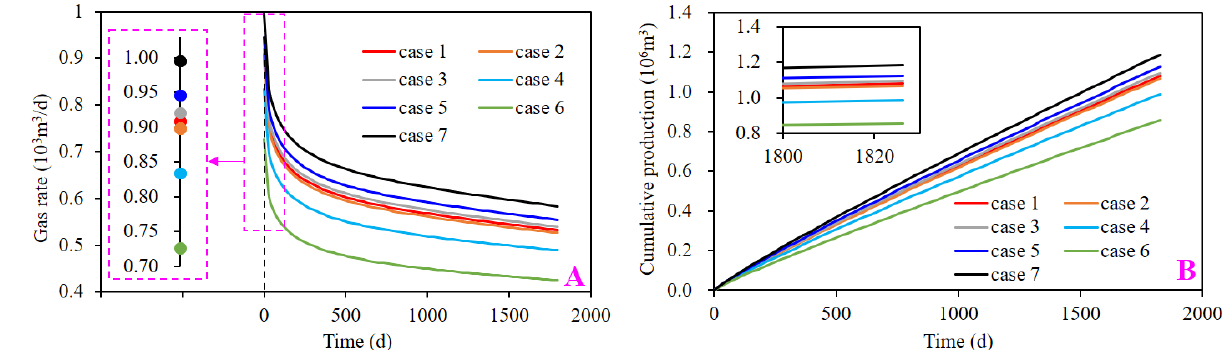
Figure 9. Simulation results of coalbed methane well production after the impaction of different imbibition degrees, ( A ) is the magnification of the intersection with the ordinate, ( B ) is the magnification of the cumulative production between 1800 d and 1820 d.